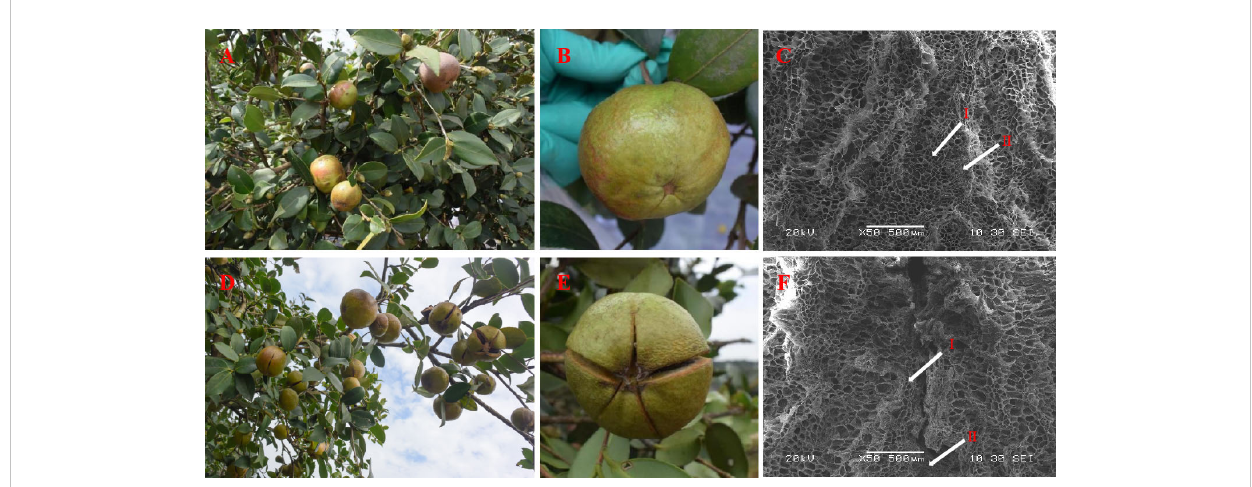
FIGURE 2 Effects of 1.5 g L -1 ethephon treatment on phenotype in fruits and shells of C. oleifera ‘ Huashuo ’ . Fruits of C. oleifera ‘ Huashuo ’ after the treatment with the control (A, B) ; Fruits of ‘ Huashuo ’ after the treatment with 1.5 g L -1 ethephon (D, E) ; Scanning electron microscopes of the shells structures of the control (C) and 1.5 g L -1 ethephon treatment (F) . The arrows indicate fi ber cells (I) and parenchyma cells (II).